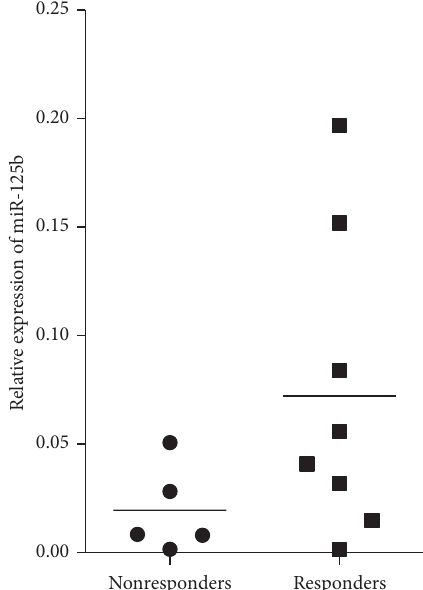
Figure 4: Serum miR-125b predicts rituximab response in B lymphoma patients. Expression levels of miR-125b were quantified by RT-qPCR as described in M&M in the serum of patients with B lymphoma before initiation of rituximab treatment. Clinical response was analyzed 4–6 weeks later and patients were considered nonresponders (NR, 𝑛 = 5 ) or responders (R, 𝑛 = 8 ) according to international